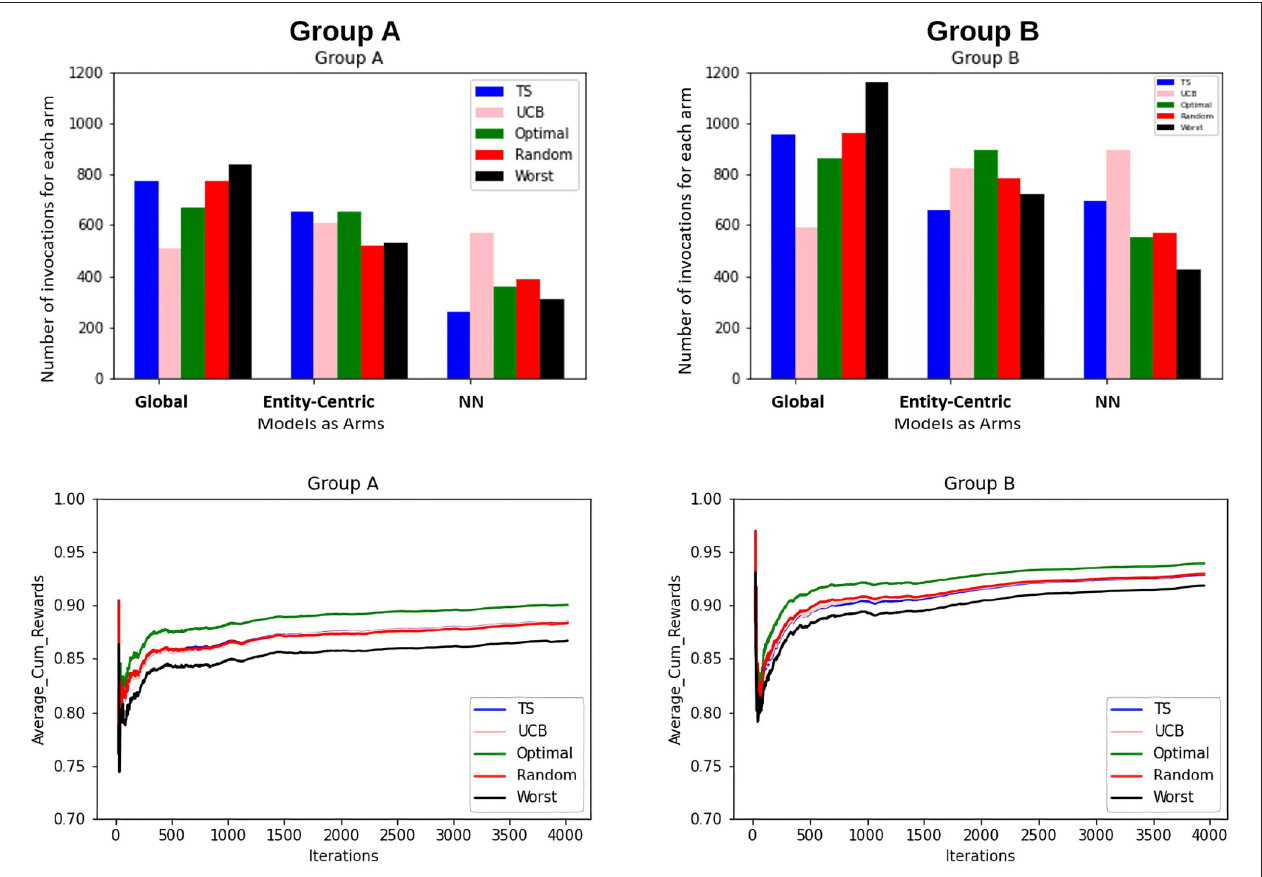
FIGURE 4 | The figure shows the combined view of both the groups for the whole vector bandit w.r.t the number of times each arm is invoked for the items by different samplers and the average cumulative reward per iteration/time-step for those items. Five samplers as discussed in Section 3.3 above have been compared here.